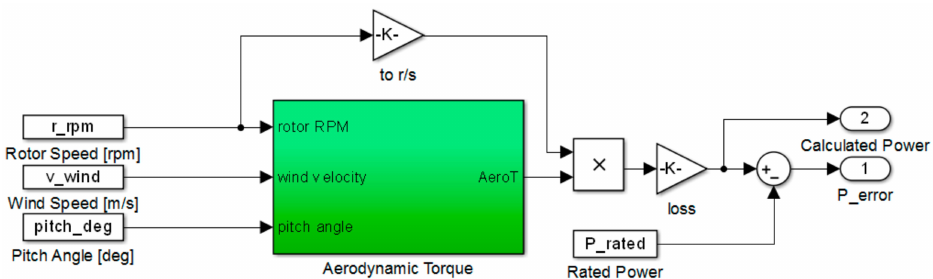
Figure 10. Block diagram of a function to produce a 3D lookup table.